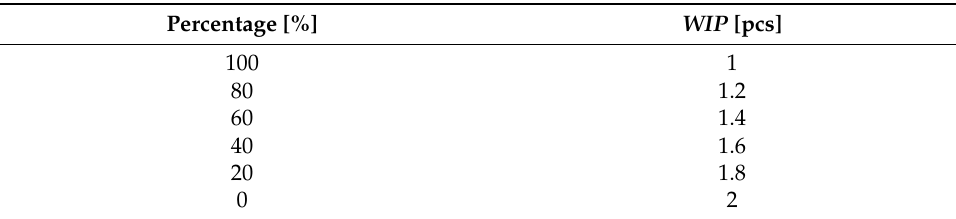
Table 8. Conversion table of 1.12 in 88%. The maturity is assumed as a linear with F T , maximal when the F T = C T and minimal when F T = 2 C T